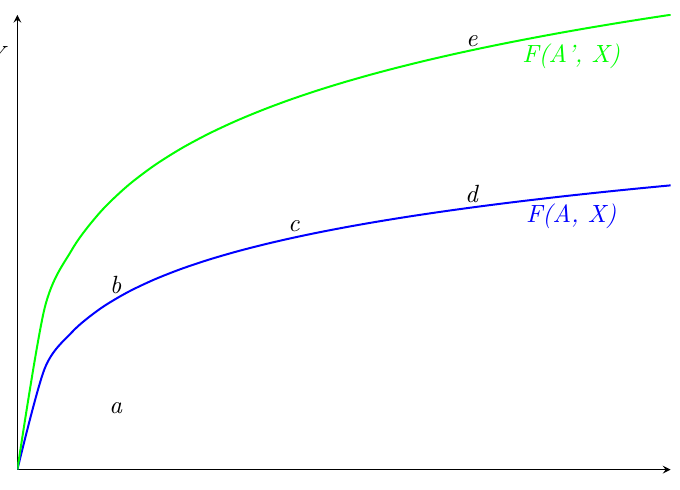
Figure 1: Production function and injection of additional